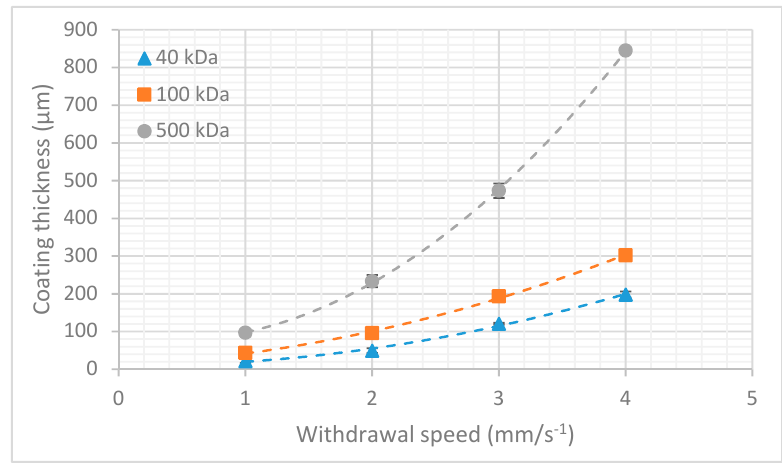
Figure 2. Coating thickness vs. withdrawal speed in function of molecular weight. The error bars represent the standard deviation ( n = 6).